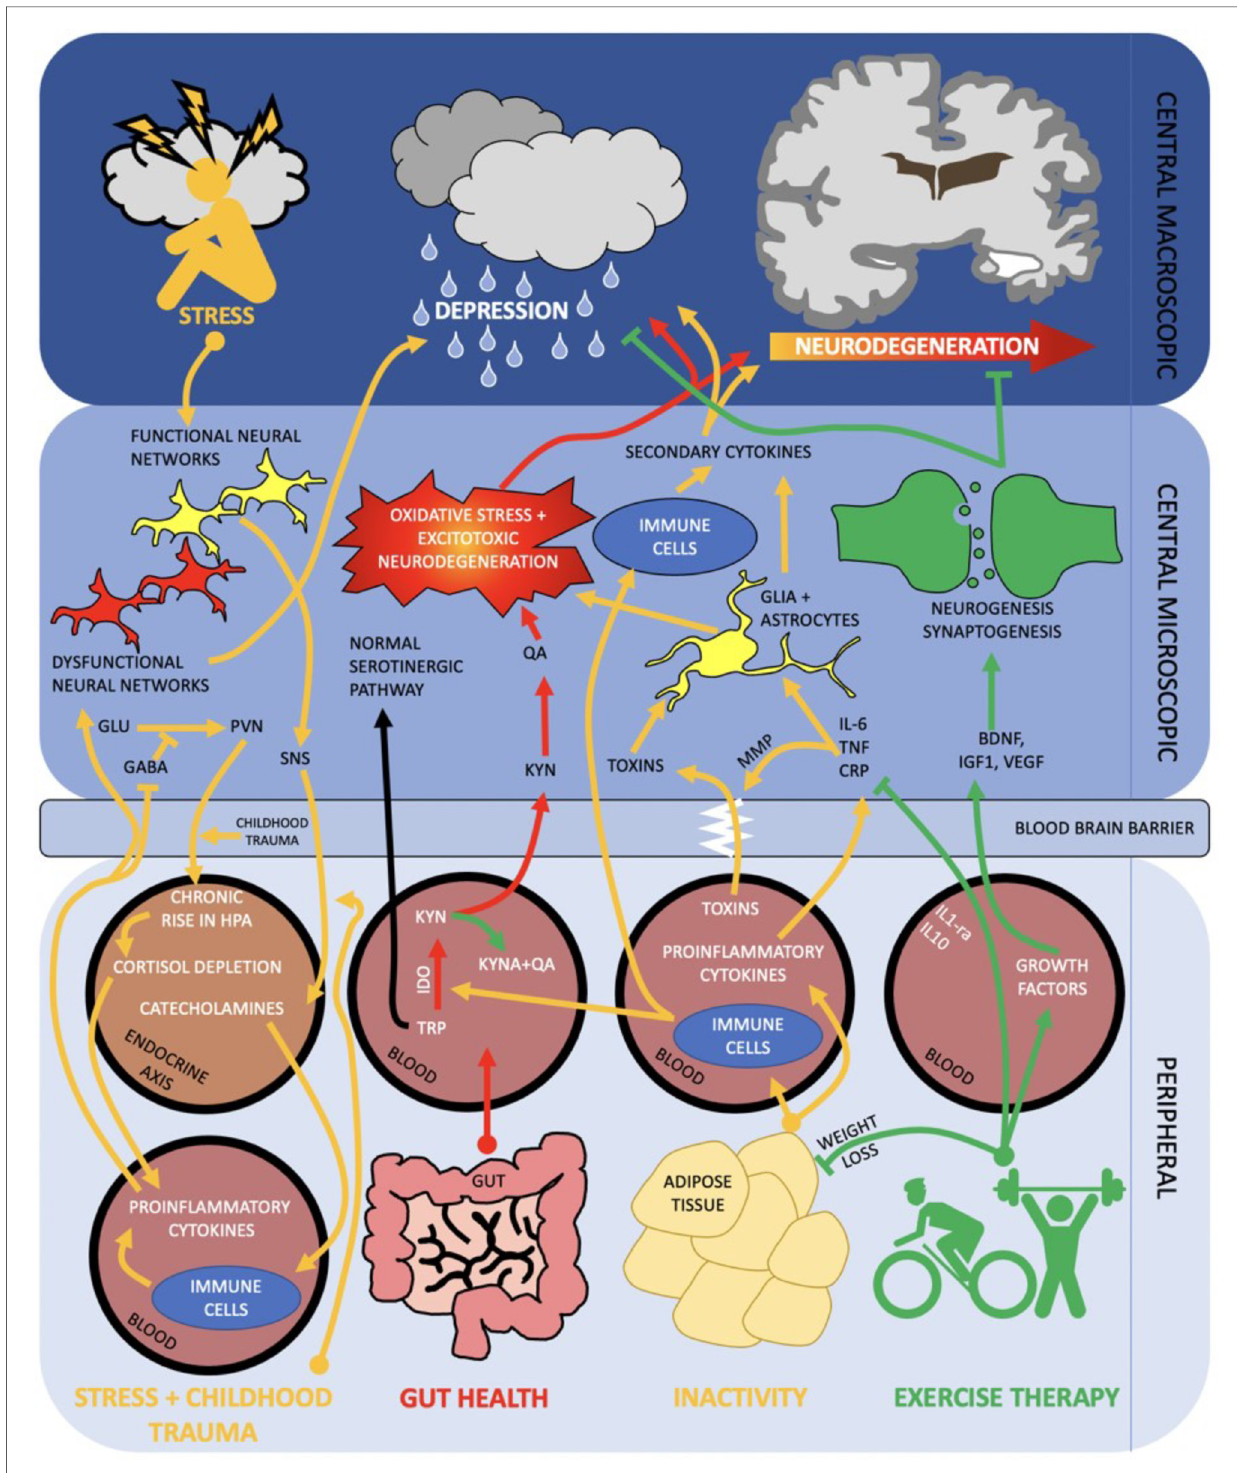
FIGURE 1 Diagram of the brain and peripheral neuroimmune interactions in terms of the gut — muscle-brain axes. RED activation of kynurenine pathway via poor gut health propagates oxidative stress and excitotoxic neurodegeneration. ORANGE inactivity and subsequent raised adiposity elicits an in fl ammatory cascade which traverses the blood brain barrier and contributes to neurodegeneration and depression. Stress and negative early life events may activate a parallel pathway, in which peripheral in fl ammation and HPA axis dysregulation contribute to dysfunctional neural networks and depression. GREEN exercise therapy both acutely (arrow) and chronically (inhibition arrow) inhibit in fl ammatory and kynurenine pathways whilst promoting neurogenesis and synaptogenesis. Combined, this can help stave off neurodegeneration and onset of depression. SNS, sympathetic nervous system; MMP, mixed metalloproteases; PV, paraventricular nucleus; IDO, indoleamine 2,3-dioxygenase; Other abbreviations described